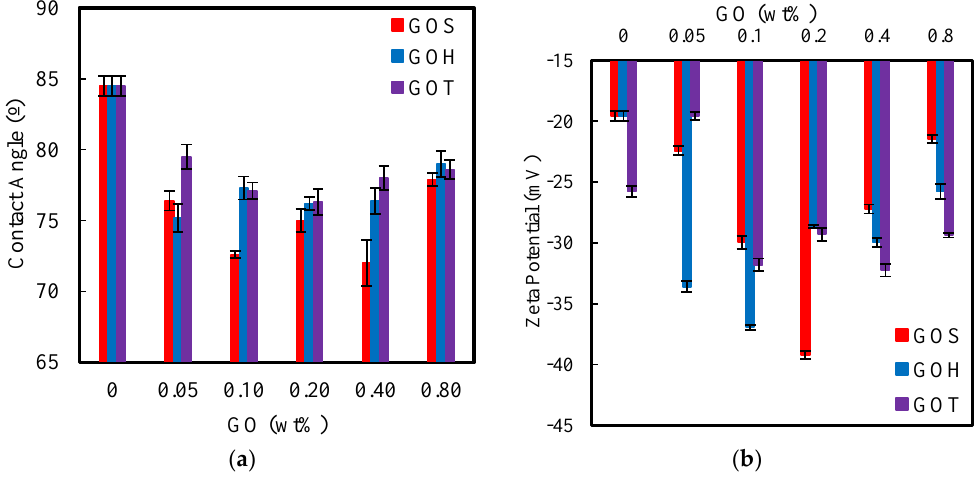
Figure 1. Contact angle ( a ) and zeta potential ( b ) of GO S , GO H and GO T membranes. Error bars indicate standard deviation .